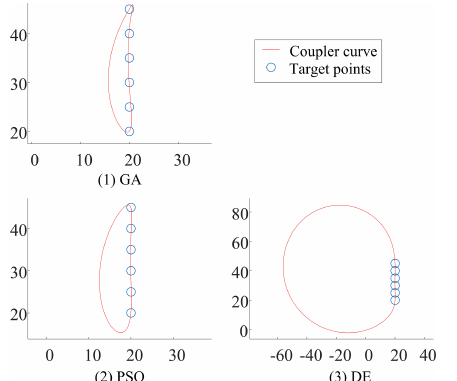
Figure 9. Coupler curves obtained in this study for Example